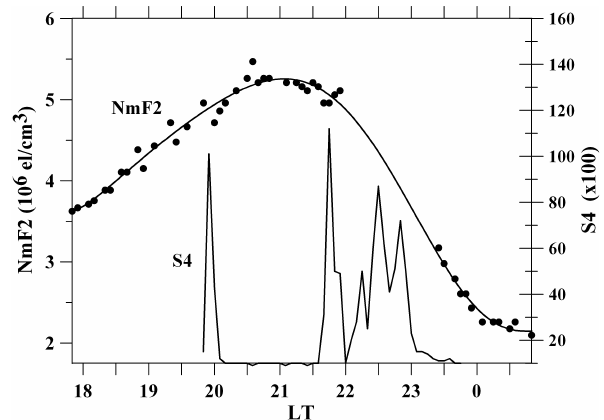
Fig. 3. Ionospheric and scintillation observations on 14–15 March 2001 showing the interpolation of Nm F2 where the scintillation ir- regularities obscure its direct